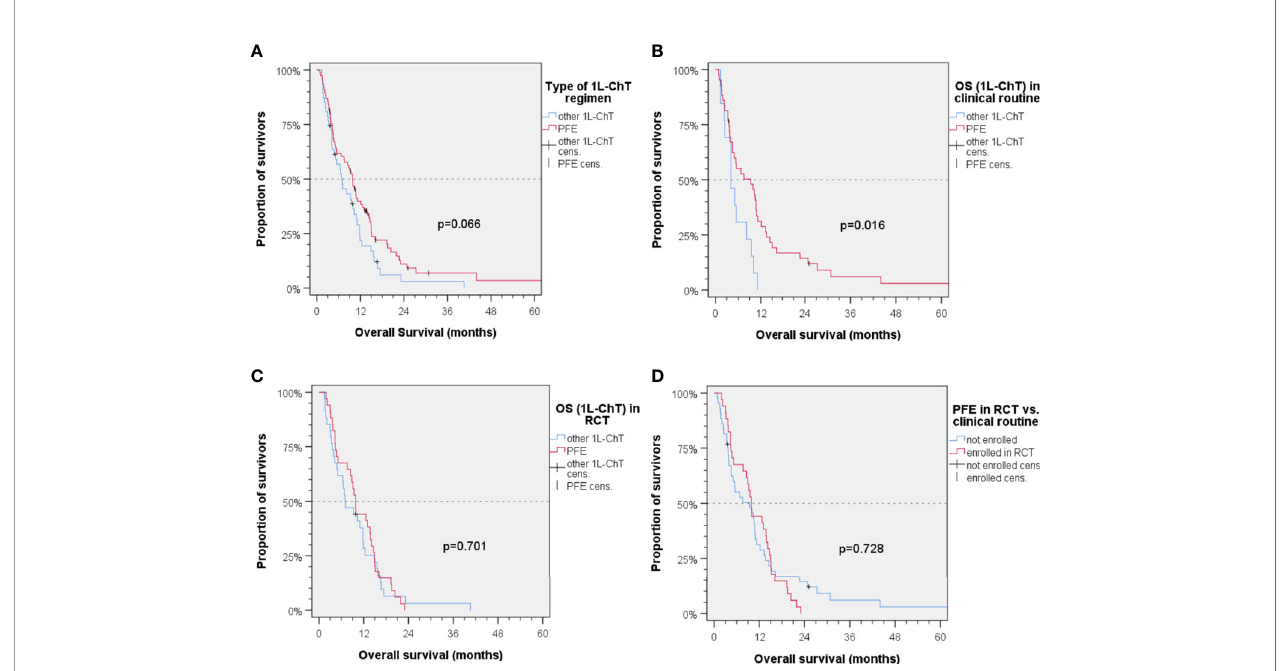
FIGURE 2 | Kaplan – Meier plots for cumulative overall survival (OS 1L-ChT ) measured from diagnosis of incurable recurrent/metastatic head and neck squamous cell carcinoma receiving fi rst-line chemotherapy as indicated; (A) OS 1L-ChT after PFE according to the EXTREME protocol vs . other 1L-ChT regimens; (B) OS 1L-ChT of patients receiving outside randomized controlled trials (RCT) PFE vs . other 1L-ChT regimens; (C) OS 1L-ChT of patients receiving PFE vs . other 1L-ChT within RCT; (D) OS 1L-ChT of patients receiving PFE in RCT vs . outside RCT; P values shown are from 2-sided log-rank